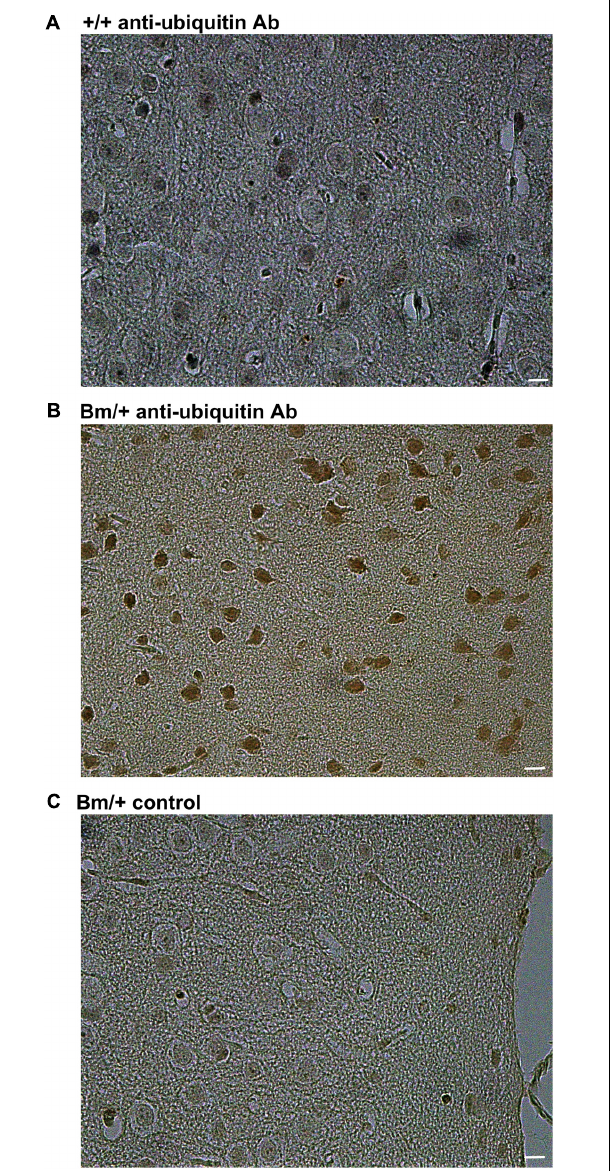
FIGURE 3 | Ubiquitinated proteins are more obvious in the cerebral cortex of mutant BiP mice. Cortical tissue from (A) a wild-type mouse (+/+, 24 months old) and (B) a littermate mutant BiP mouse (Bm/+, 24 months old), which was stained with an anti-ubiquitin antibody followed by a secondary antibody. (C) As a negative control, cortex from a mutant BiP mouse (Bm/+, 24 months old) was incubated with saline followed by the secondary antibody. Scale bars, 10 µ